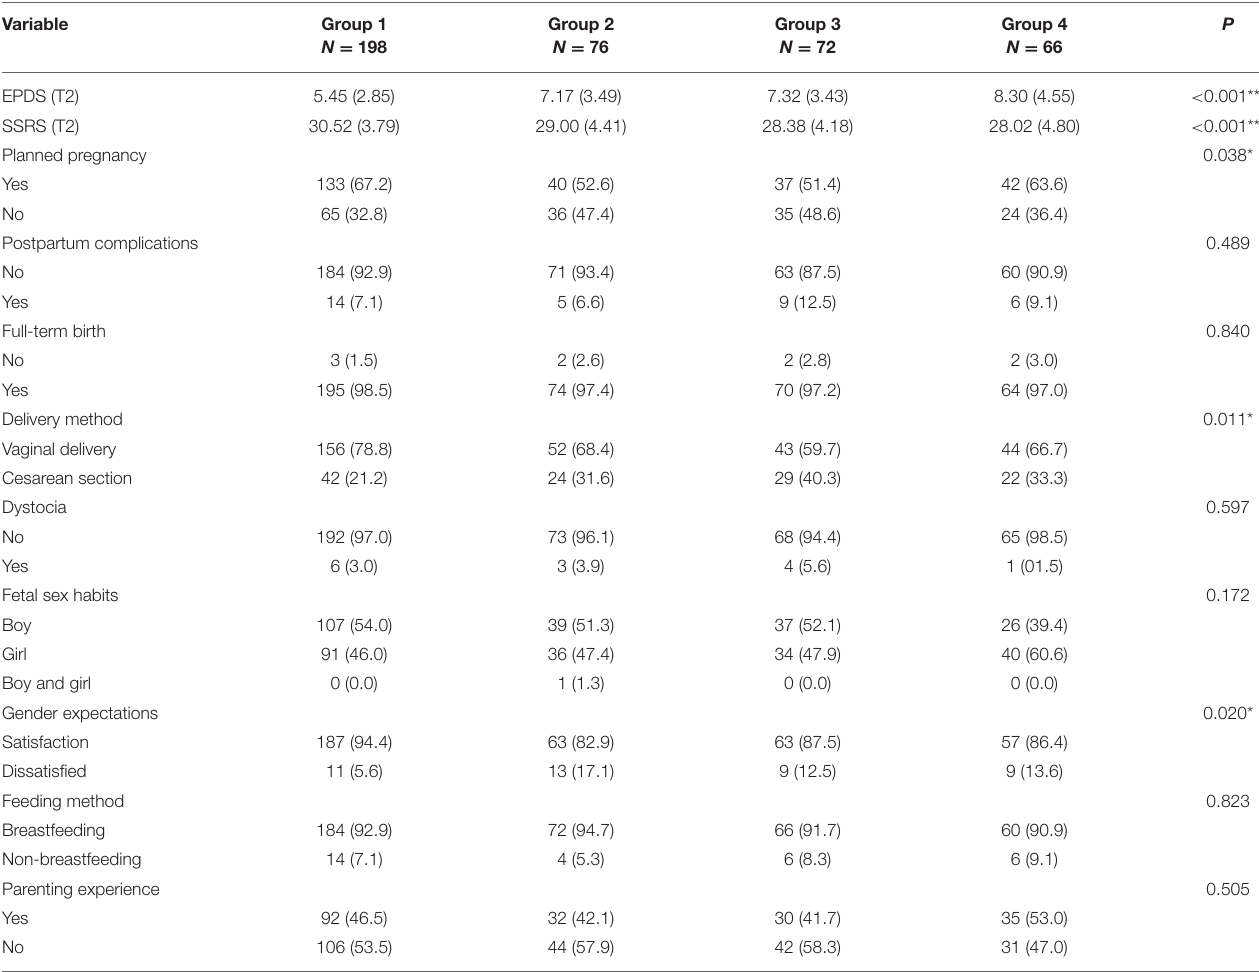
TABLE 3 | Comparison among the sleep trajectory groups after delivery.